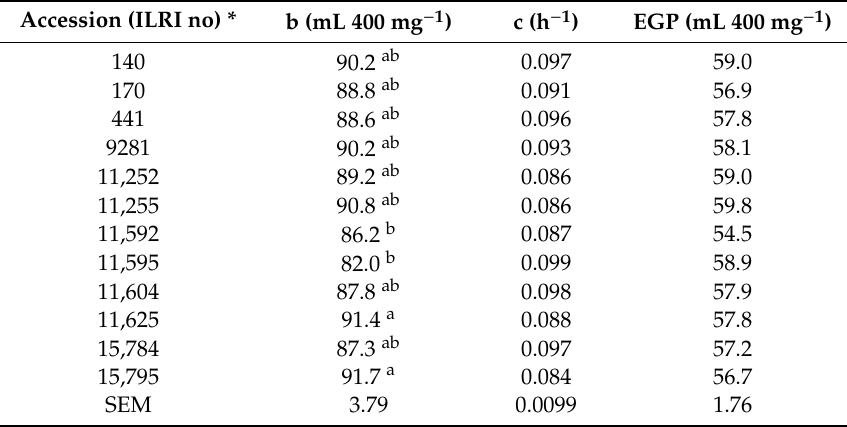
Table 6. Gas kinetics parameters for di ff erent forages of S. scabra accessions adapted in climatic condition of Pretoria.